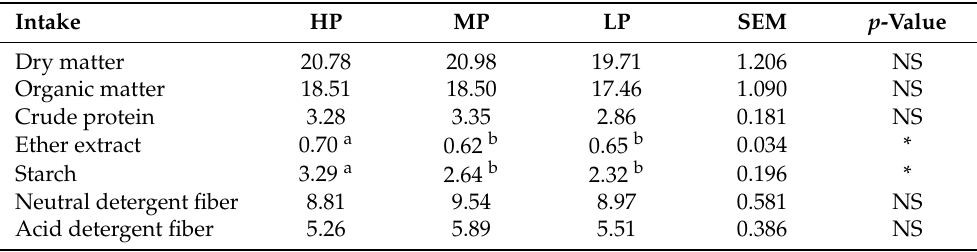
Table 2. Nutrient intake (kg/day, dry matter basis) by dairy cows feeding diets with high protein (HP), medium protein (MP), and low protein (LP) levels. Intake HP MP LP SEM